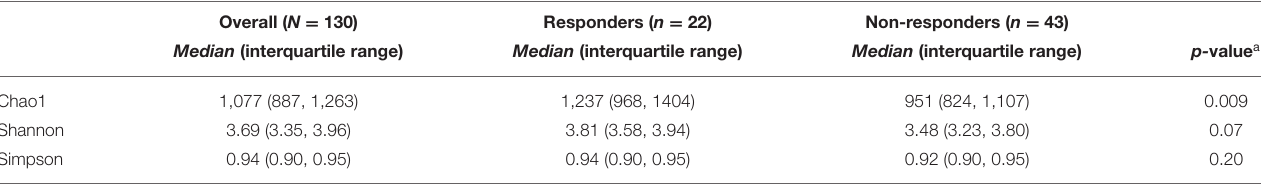
TABLE 2 | α -diversity of each